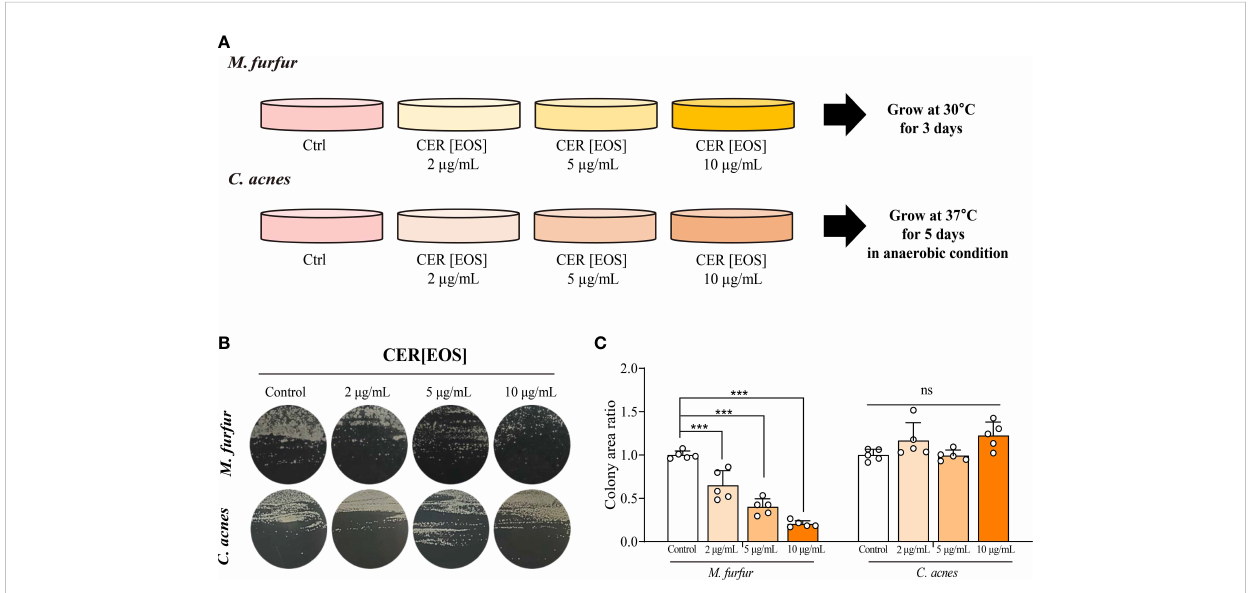
FIGURE 7 Inhibitory effect of OS-type ceramide on the colonization of M. furfur. (A) Representative image showing the gross morphology of colonies from (up) M. furfur and (down) C . acnes. (B) Quanti fi ed area of colonies from (left) M. furfur and (right) C . acnes. (Five replicates for each column, Tukey ’ s multiple comparisons test; control vs. 2 m g/mL; p< 0.001, control vs. 5 m g/mL; p< 0.001, control vs. 10 m g/mL; p< 0.001). *** : p<0.001; ns, Not Signi fi cant